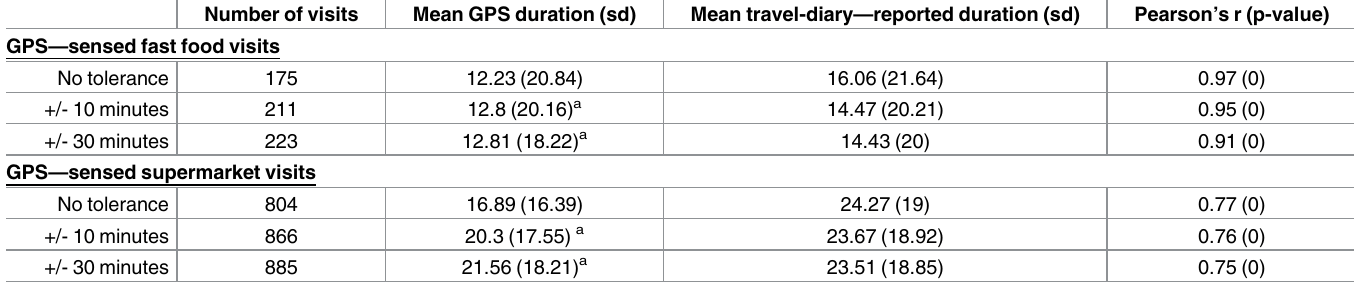
Table 3. Visit durations for GPS—sensed visits